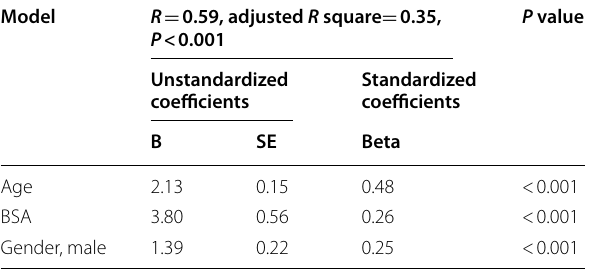
Table 30 Linear regression analysis to predict mean aortic diameter at diaphragmatic level